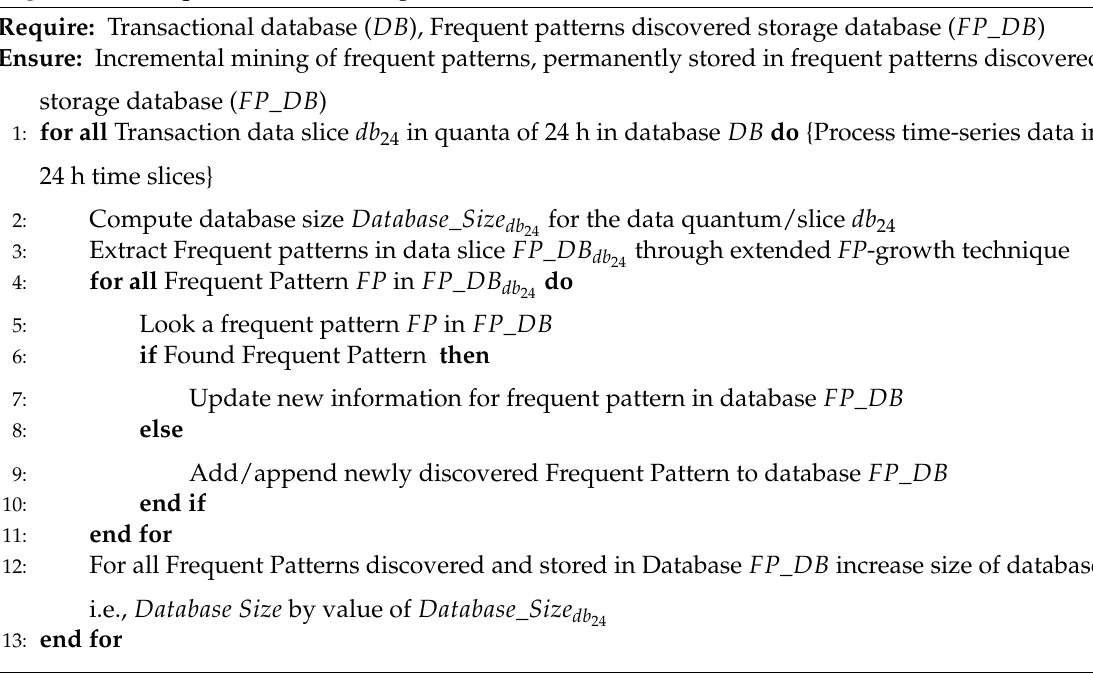
Algorithm 1 Frequent Pattern mining: